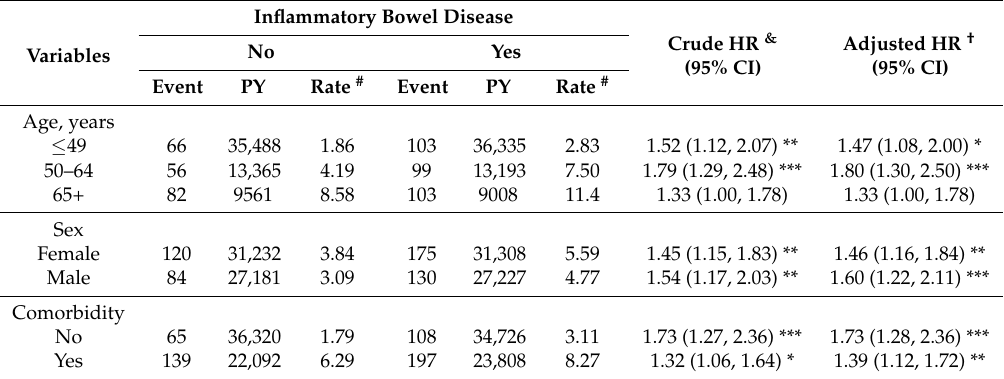
Table 3. Cox model-measured incidence of cholelithiasis stratified by age, sex, and comorbidities and hazard ratios for patients with and without inflammatory bowel disease.